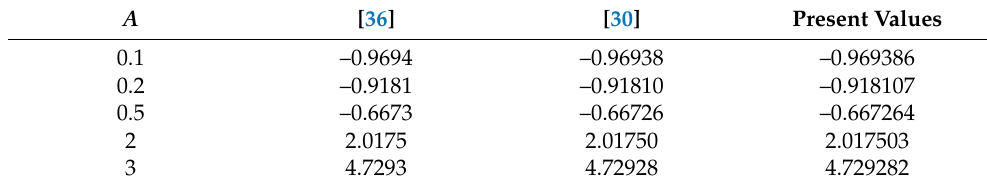
Table 2. Comparison of C f Re 1/2 x for pure